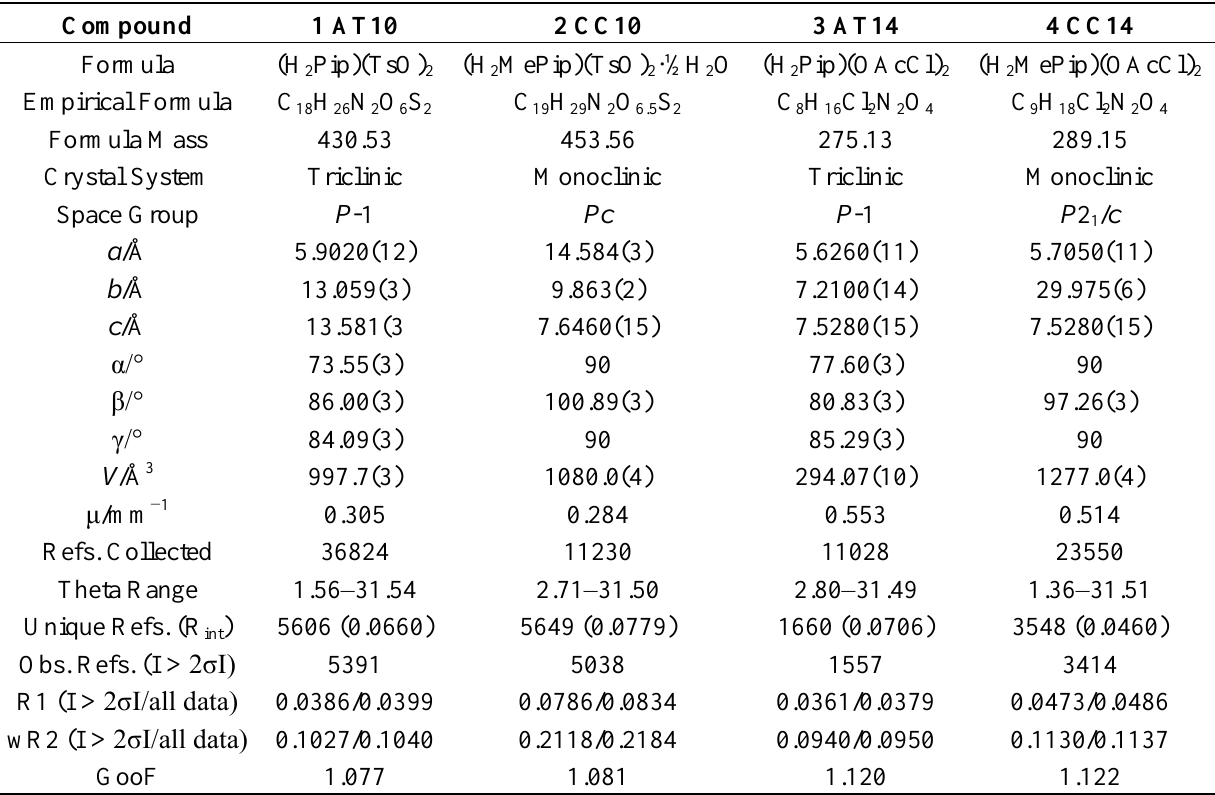
Table 3. Crystallographic and refinement data for compounds 1 – 4